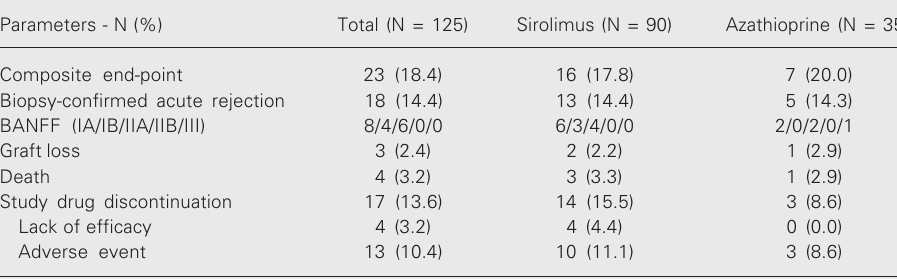
Table 2. Efficacy and safety analysis one year after kidney transplantation. Parameters - N